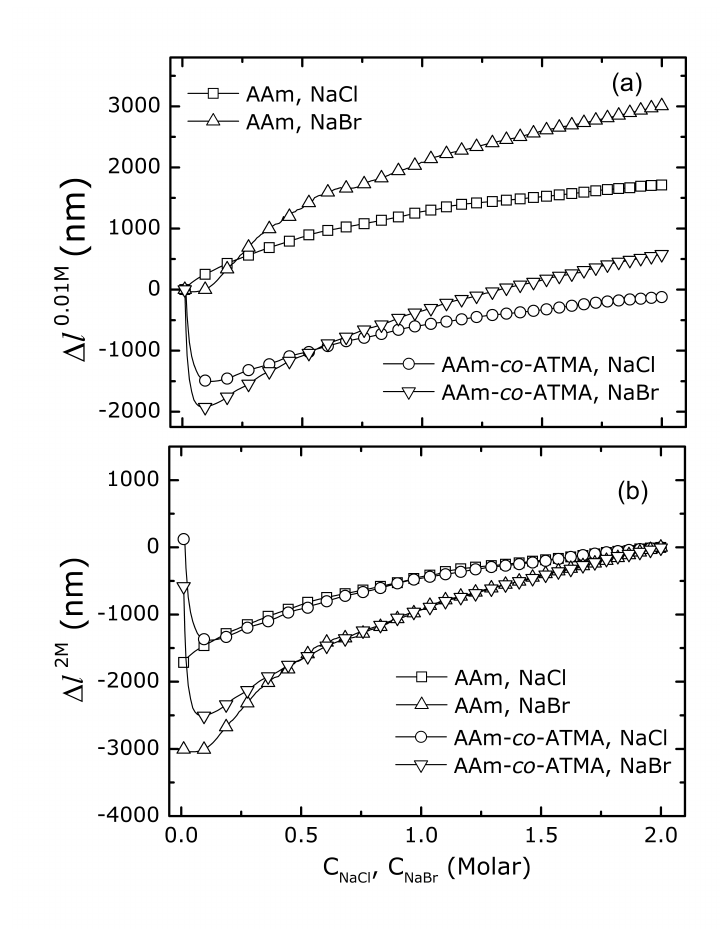
Figure 3. Change in the physical length of AAm and AAm- co -ATMA hydrogels versus NaCl or NaBr concentration in aqueous solution. The change in the length of the hydrogels is shown using either ( a ) 0.01 M, ∆ l 0.01 M or ( b ) 2.0 M salt, ∆ l 2.0 M as the reference condition. The equilibrium swelling data are shown (lines) with data symbols for every 10th salt concentration for uncharged AAm and 3 mol% ATMA hydrogels in the type of salt as indicated by the symbols. The standard deviations of the changes in the physical length estimated from data similar to that in Figure 2 were found to be in the range 1–5 nm, which is less than the size of the symbols in the current graph. The physical length along the optical axis of the fiber was 36 µ m (10 mM salt) within 3 % for all the